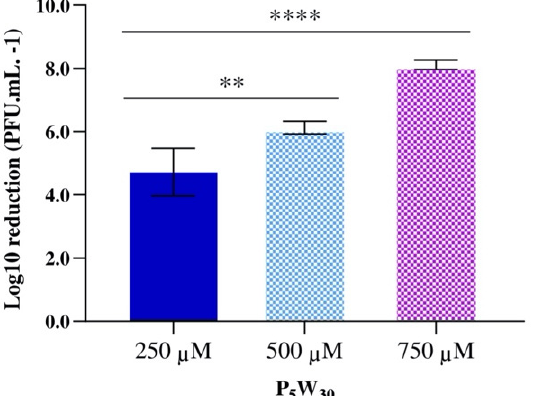
Figure 9. Antiviral activity of the compound P 5 W 30 against the enterovirus Q β . Data are expressed as the mean of three biological and three technical replicates. The error bars represent the standard deviation. **** p < 0.0001, ** p < 0.05.